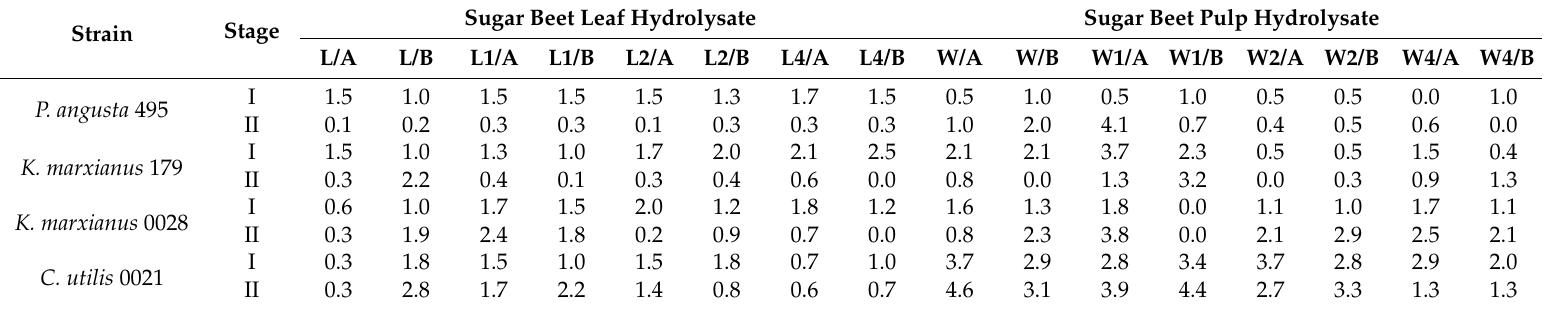
Table 6. Growth of selected non-conventional yeast strains on biomass hydrolysates (increase in optical density ( ∆ McF)). Strain Stage